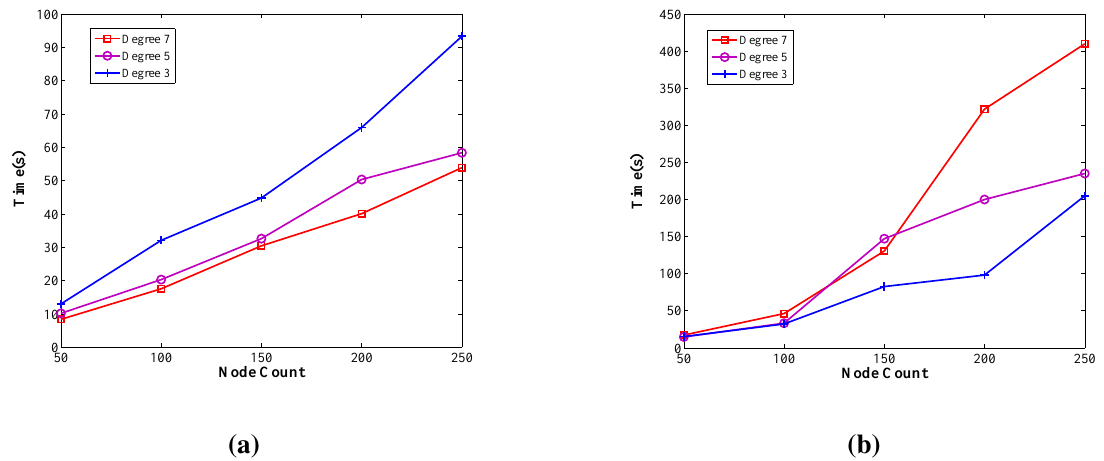
Figure 18. Wall clock times of ABIDE and E-MILIC algorithms against node count and degree. ( a ) Wall clock times of ABIDE; ( b ) wall clock times of